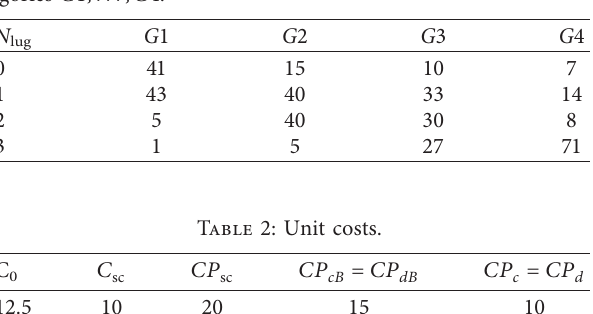
Table 1: Percentage distribution of variable N egories G 1 , ... ,G 4.